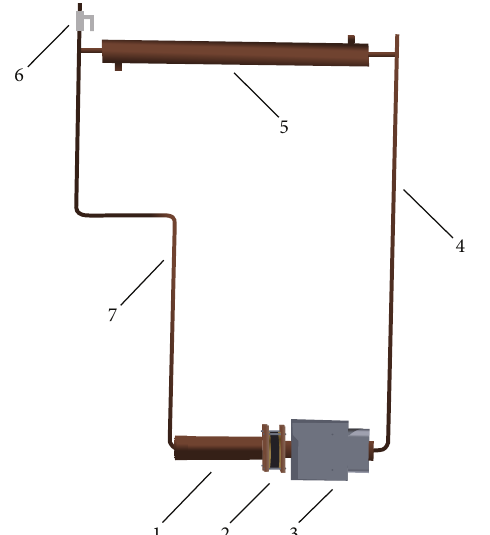
Figure 6: Model of design LHP: 1: compensation chamber, 2: rubber seal, 3: evaporator, 4: vapor line, 5: condenser, 6: filling valve, and 7: liquid line.